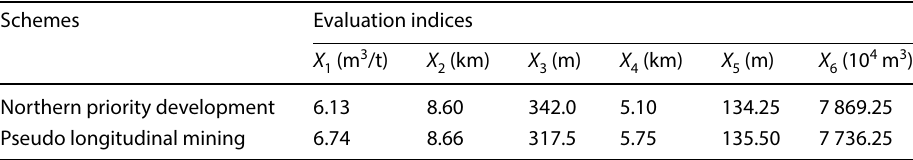
Table 8 Summary of mining and dumping scheme evaluation indices in anticline region